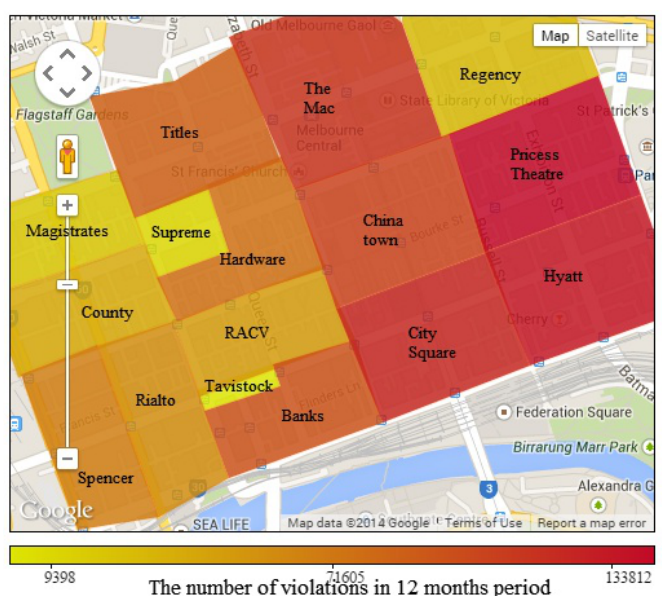
Figure 5. Parking violation distribution by